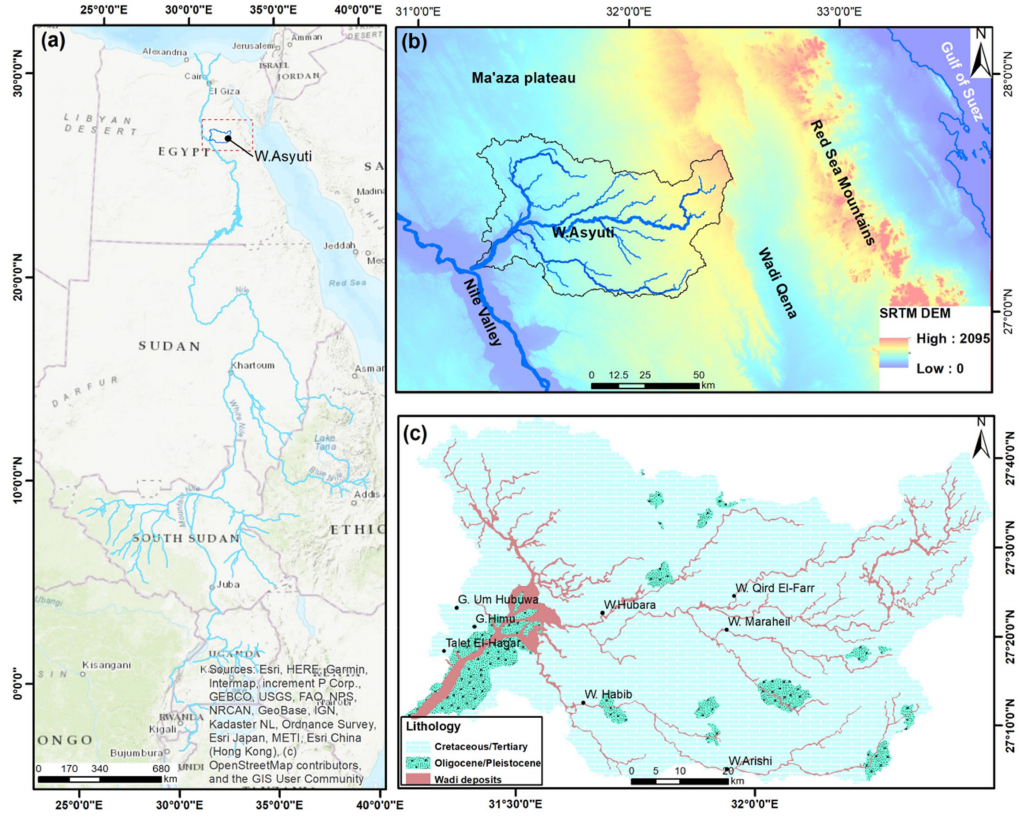
Figure 1. ( a ) Location of Wadi Asyuti in the northern part of the Nile basin; ( b ) SRTM DEM overlaid by Wadi Asyuti; ( c ) Geological map of the W. Asyuti basin (Conoco, 1987)